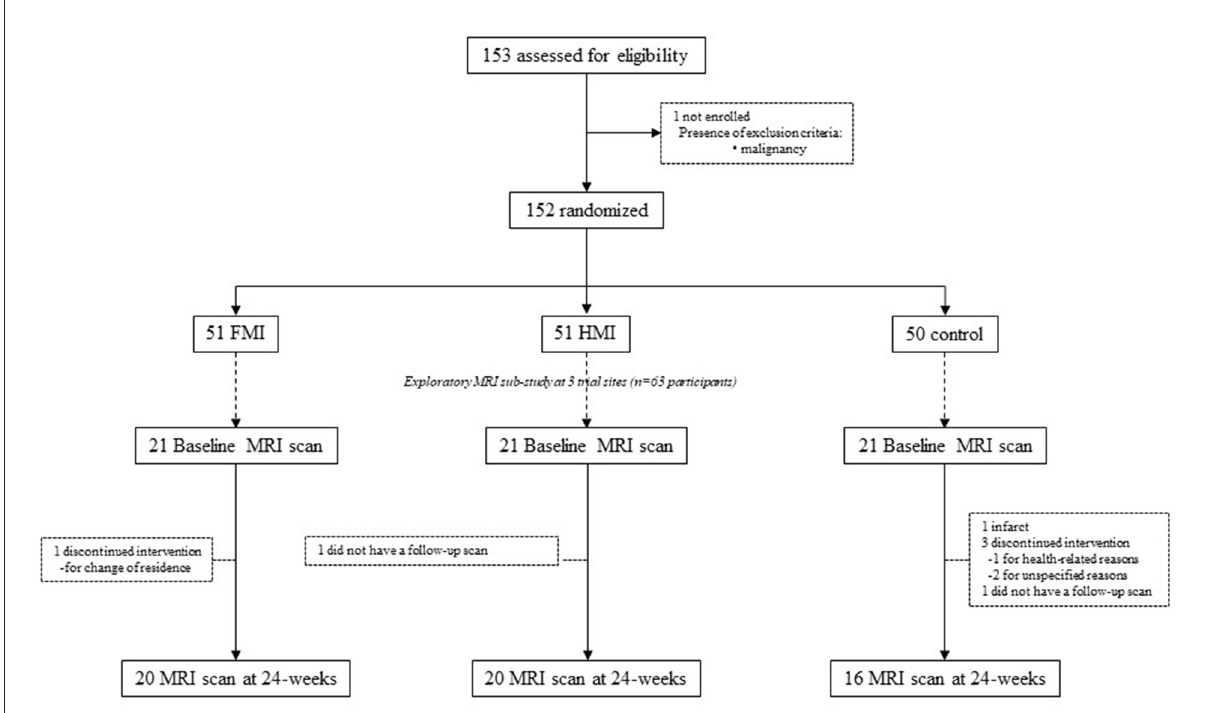
FIGURE1 Diagram depicting the exploratory MRI analyses in the SUPERBRAIN trial. SUPERBRAIN, South Korean Study to Prevent Cognitive Impairment and Protect Brain Health Through Lifestyle Intervention; MRI, magnetic resonance imaging; FMI, facility-based multidomain intervention; HMI, home-based multidomain